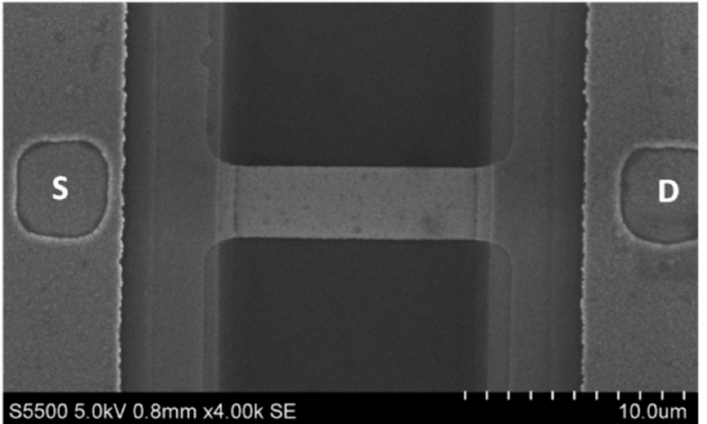
Figure 2. SEM image of an individual nanoribbon and ohmic contacts. The D and S letters indicate drain and source contacts,